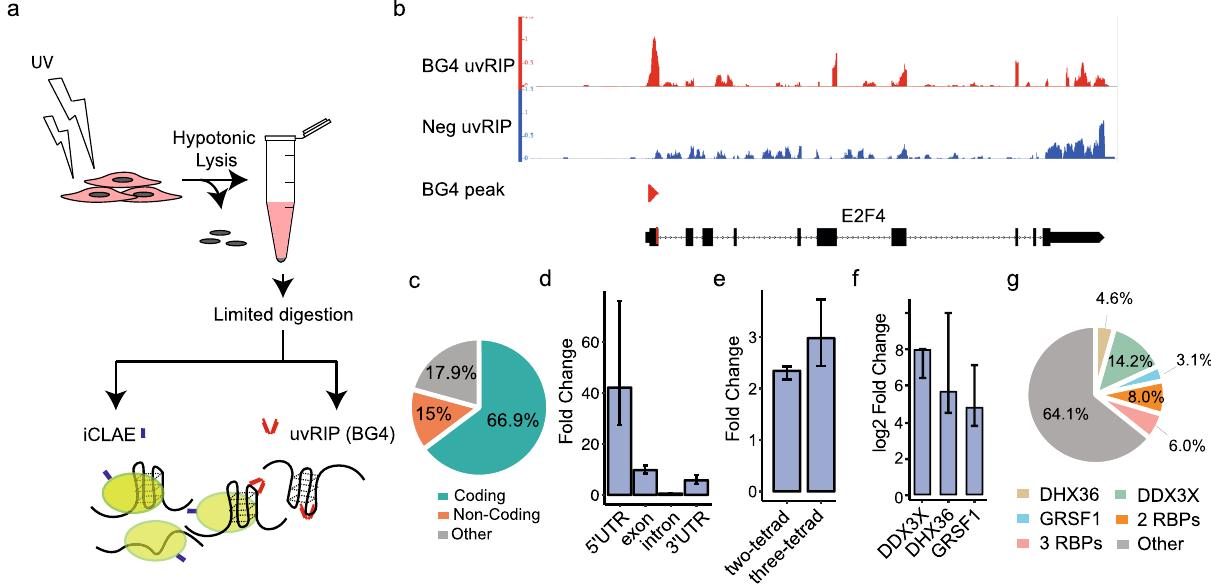
Figure 2. Identification of cellular G4s using BG4 uvRIP. ( a ) Experimental strategy. ( b ) Example snapshot of BG4 uvRIP peak in the 5 ′ UTR of E2F4 gene. A negative control is provided by uvRIP using a non-G4 specific A9 antibody. ( c ) Overlap of BG4 uvRIP peaks with protein-coding, non-coding or unannotated regions of the genome. ( d ) Enrichment of BG4 uvRIP peaks within annotated RNA features. ( e ) Enrichment of G4 motifs within BG4 uvRIP peaks. ( f ) Enrichment of BG4 uvRIP peaks within iCLAE sites for DDX3X, DHX36 and GRSF1. For ( d–f ) enrichment calculated following random shuffling of peaks in the transcriptome. ( g ) Percentage overlap of BG4 uvRIP peaks with iCLAE datasets for DDX3X, DHX36 and